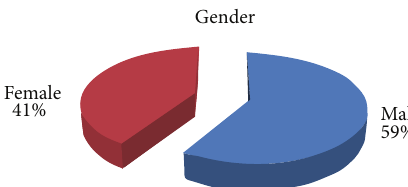
Figure 1: Gender of subjects in the sample. Percentage of distribu- tion of studied sample in relation to gender ( 𝑛 = 100 ).